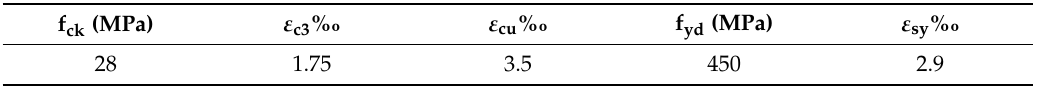
Table 2. Materials